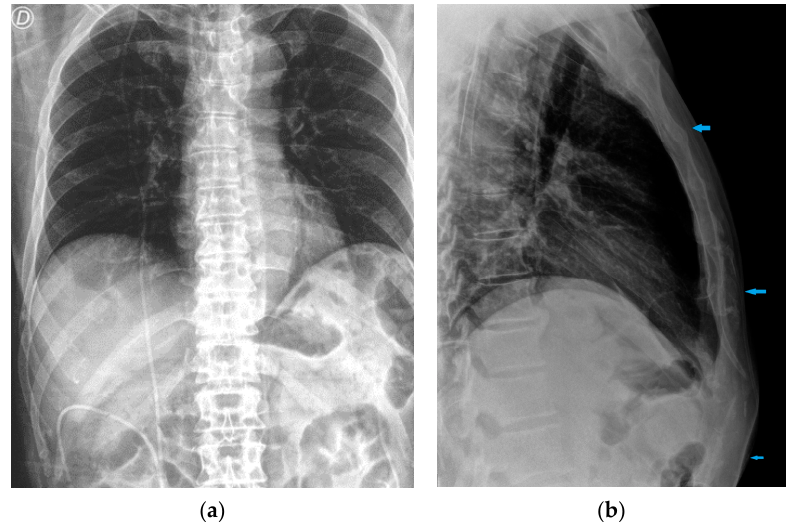
Figure 32. Image of the subcutaneous course (blue arrows) of a VP shunt on CXR, PA ( a ) and LL ( b ) views. When only the PA projection is available, it is important not to misinterpret the thoracic course of the VP shunt as a misplaced CVC.